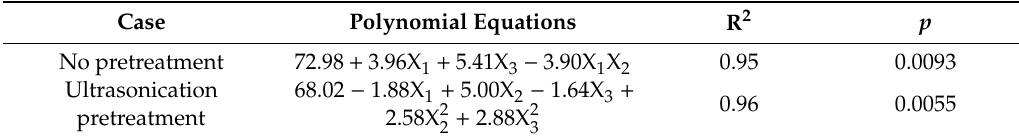
Table 3. Mathematical models (equations) derived after implementing response surface methodology (Box–Behnken design).